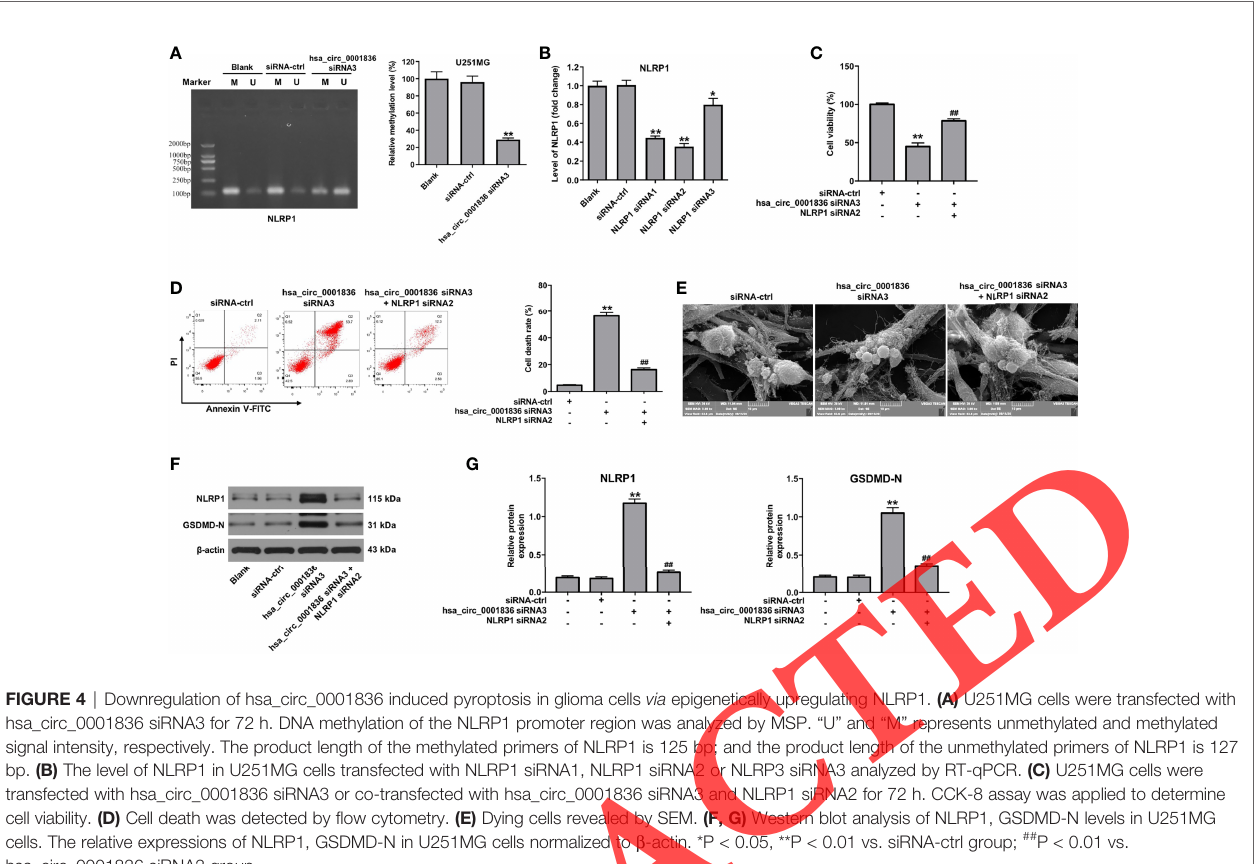
FIGURE 4 | Downregulation of hsa_circ_0001836 induced pyroptosis in glioma cells via epigenetically upregulating NLRP1. (A) U251MG cells were transfected with hsa_circ_0001836 siRNA3 for 72 h. DNA methylation of the NLRP1 promoter region was analyzed by MSP. “ U ” and “ M ” represents unmethylated and methylated signal intensity, respectively. The product length of the methylated primers of NLRP1 is 125 bp; and the product length of the unmethylated primers of NLRP1 is 127 bp. (B) The level of NLRP1 in U251MG cells transfected with NLRP1 siRNA1, NLRP1 siRNA2 or NLRP3 siRNA3 analyzed by RT-qPCR. (C) U251MG cells were transfected with hsa_circ_0001836 siRNA3 or co-transfected with hsa_circ_0001836 siRNA3 and NLRP1 siRNA2 for 72 h. CCK-8 assay was applied to determine cell viability. (D) Cell death was detected by fl ow cytometry. (E) Dying cells revealed by SEM. (F, G) Western blot analysis of NLRP1, GSDMD-N levels in U251MG cells. The relative expressions of NLRP1, GSDMD-N in U251MG cells normalized to b -actin. *P < 0.05, **P < 0.01 vs. siRNA-ctrl group; ## P < 0.01 vs. hsa_circ_0001836 siRNA3 group.